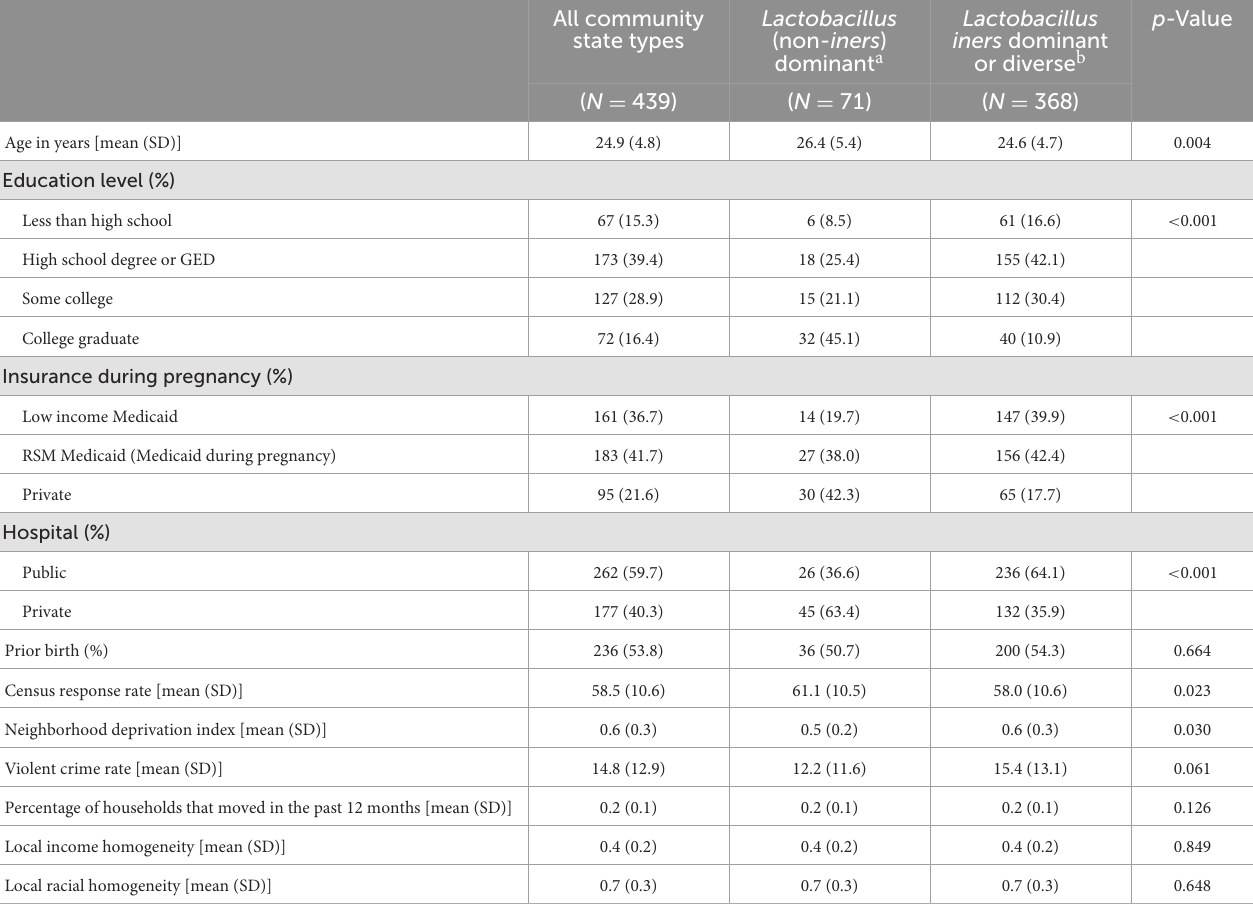
TABLE 1 Socio-demographic characteristics of study participants by vaginal microbiome community state type assignment.